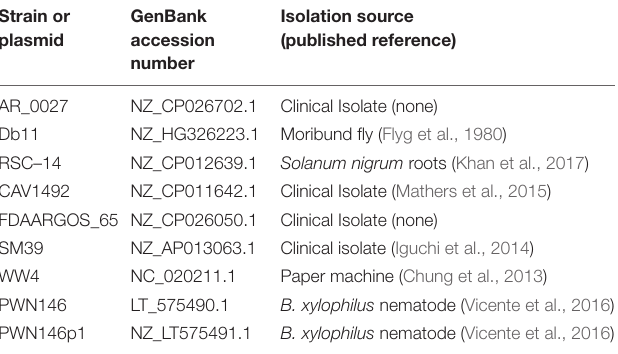
TABLE 1 | Published S. marcescens genomes used for phylogenetic comparison. Strain or